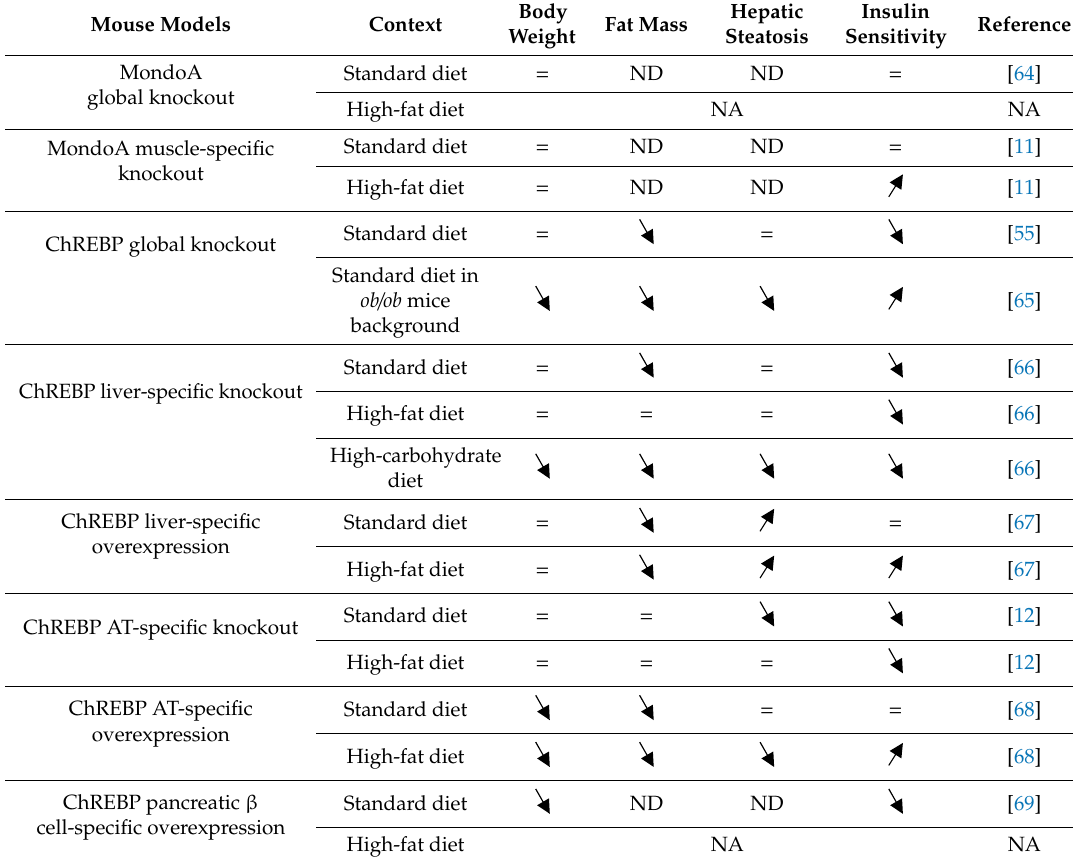
Table 2 . Summary of the reported tissue- and context-dependent roles of MondoA/ChREBP in mice